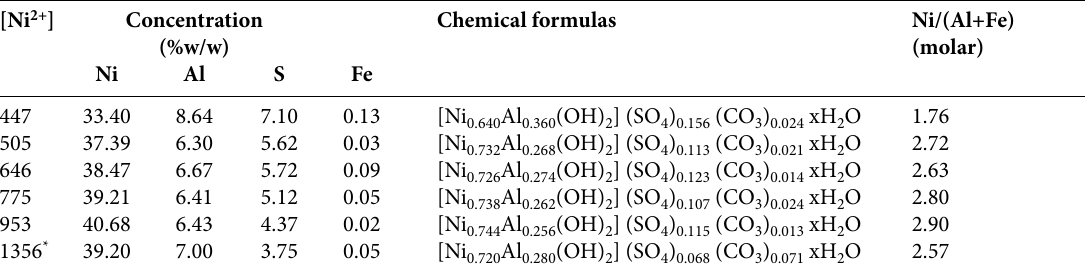
Table 6. Characterization of Ni/Al-LDH and estimated chemical formulas [Ni 2+ ] Concentration Chemical